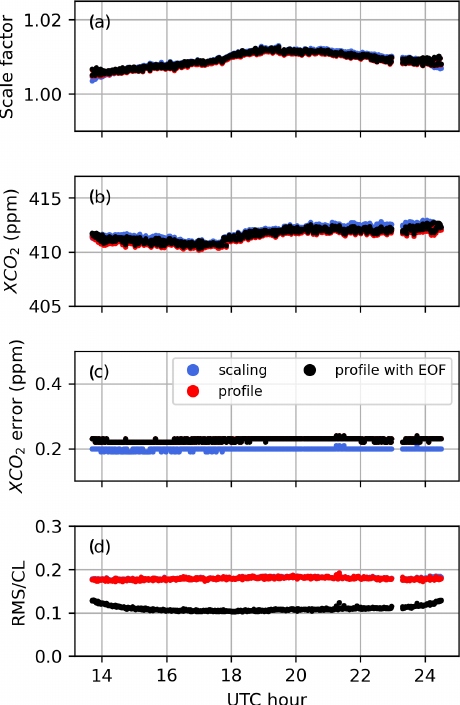
Figure E4. Same as Fig. E2 but for the TCCON2 window.